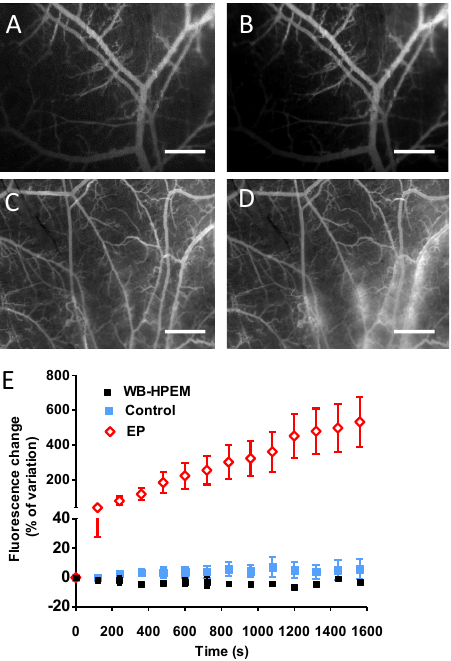
Figure 5. Vessel permeability assessment by fluorescence microscopy after intravenous injection of FITC − dextran (70 kDa) to healthy mice. Micrographs taken prior to ( A ) and after ( B ) skinfolds exposure to wide − band (WB) signals generated within the dedicated HPEM applicator. Micrographs taken from the positive control, prior to ( C ) and ( D ) after application of pulsed electric field, which has a recognized vessel permeabilizing action. ( E ) Relative mean fluorescence intensity measurements outside the vessels as a function of time during and after illumination (N = 3